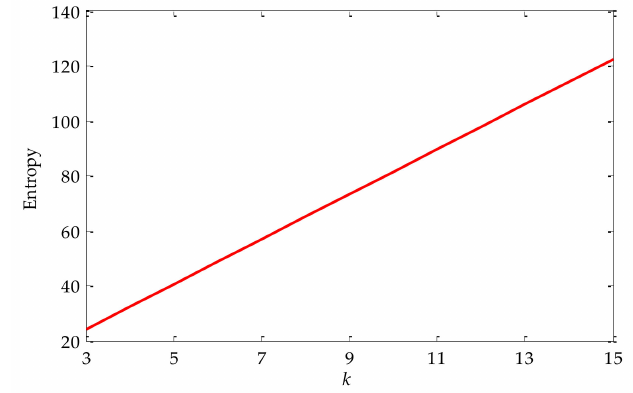
Figure 7. Curve of fitness varying with k